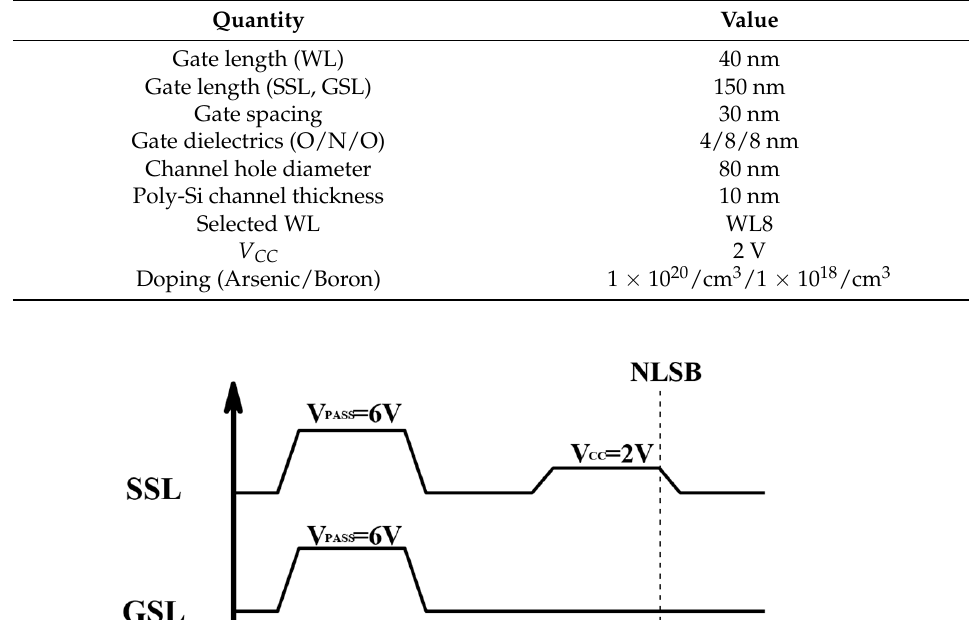
Table 1. Device parameters used in the simulation.